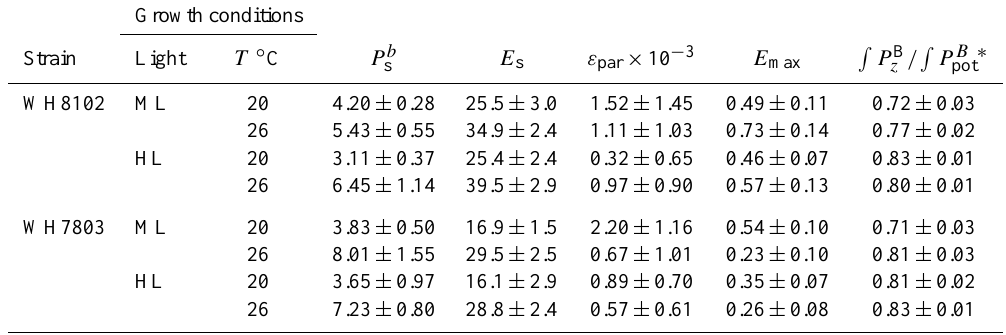
Table 4. Fitted parameters for the E max model, mean ± standard errors for n ≥ 3 experiments under each condition. Growth